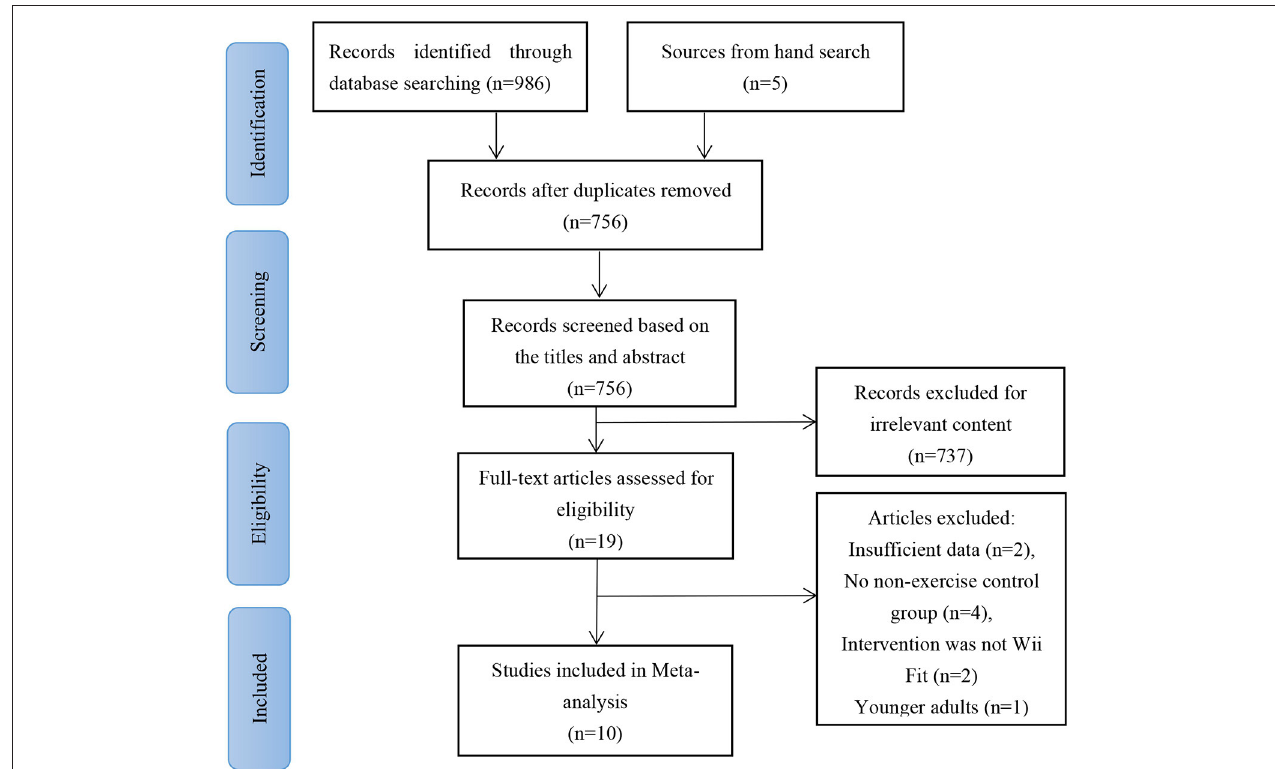
FIGURE 1 | PRISMA